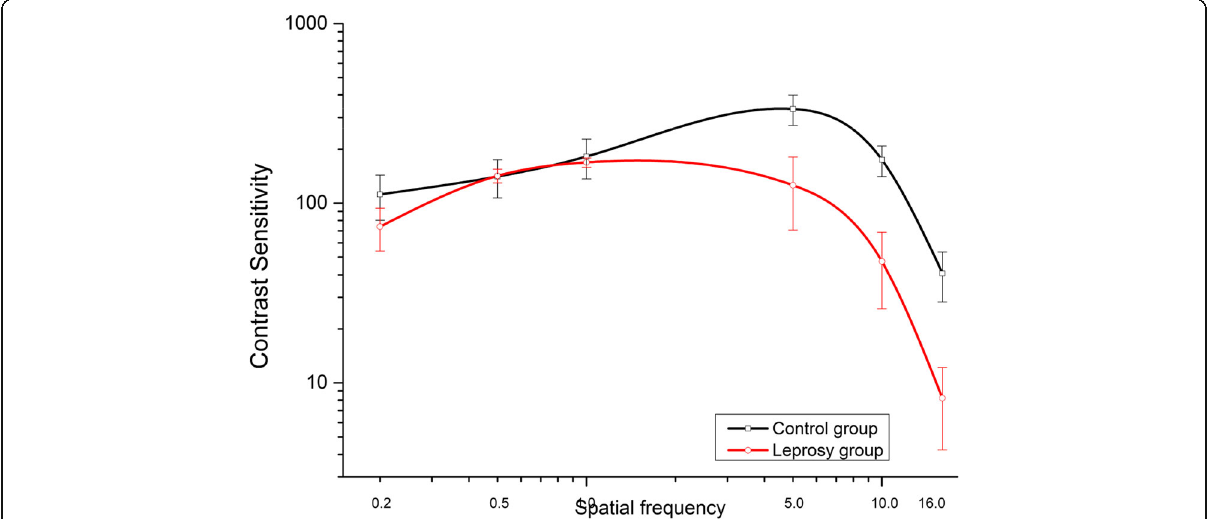
Fig. 1 Visual contrast curves plotted as a function of spatial frequencies (cpd) for subjects with normal vision and